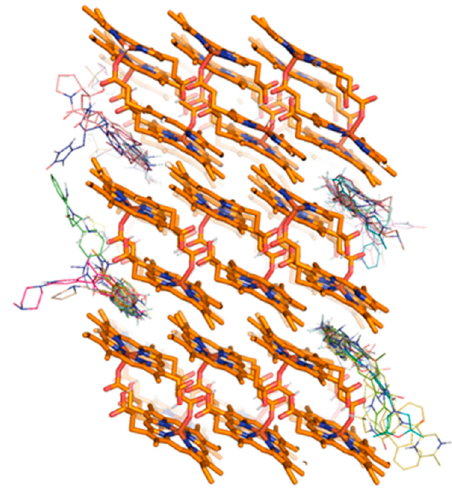
Figure 1. 3D structure of the β -haematin crystal showing the top ranked drugs by Vina binding energy exhibiting a preference for the crevices within the [001] and [00 1(cid:3364) ] faces.